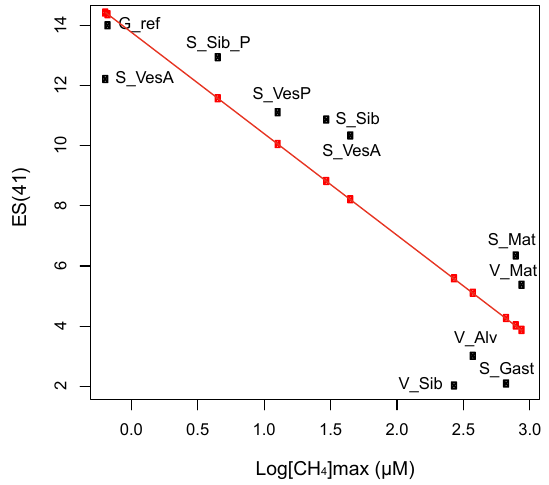
Figure 5. Rarefaction curves on pooled macrofaunal abundances from each assemblage.